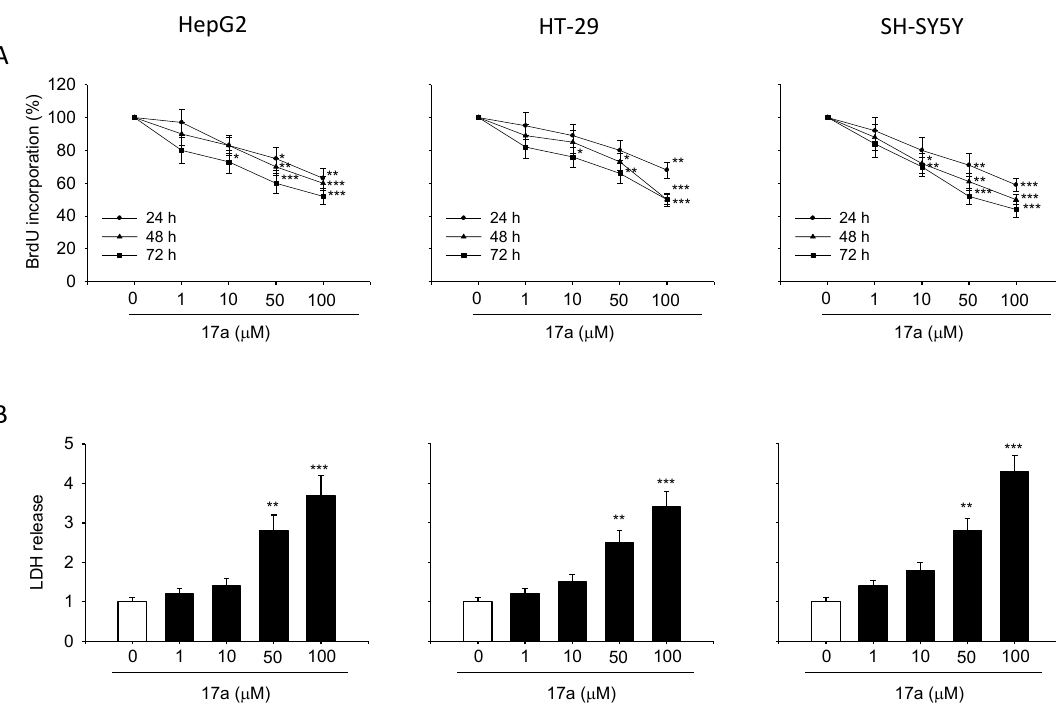
Figure 4. Compound 17a reduces cell proliferation and induce LDH release. HepG2, HT-29 and SH-SY5Y cells were exposed to increased concentration of 17a compound for 24, 48 and 72 h. ( A ) Proliferation rate assessed by BrdU assay. ( B ) Cytotoxic effect assessed in terms of LDH release after 24 h of exposure. Each value is the mean ± S.E.M. of three experiments performed eight times (BrdU) or in triplicate (LDH) and repeated three different times. * p < 0.05 vs. ctrl, ** p < 0.01 vs. ctrl, *** p < 0.001 vs. ctrl. In particular, data of the BrdU assay shows that the growth inhibitory effect induced by 17a reaches the 50% in both HepG2 and HT-29 cells and increases up to 56% in the SH-SY5Y cell line ( p < 0.001 vs. control) after 72 h of incubation at a 100 µM concentration. Reduction of cell proliferation was also observed when the cells were exposed for 48 ( p < 0.001 vs. control) and 24 hours ( p < 0.01 vs. control in HepG2 and HT-29 cells and p < 0.001 in SH-SY5Y cell line; Figure 4A) to 100 µM concentration of the compound 17a .